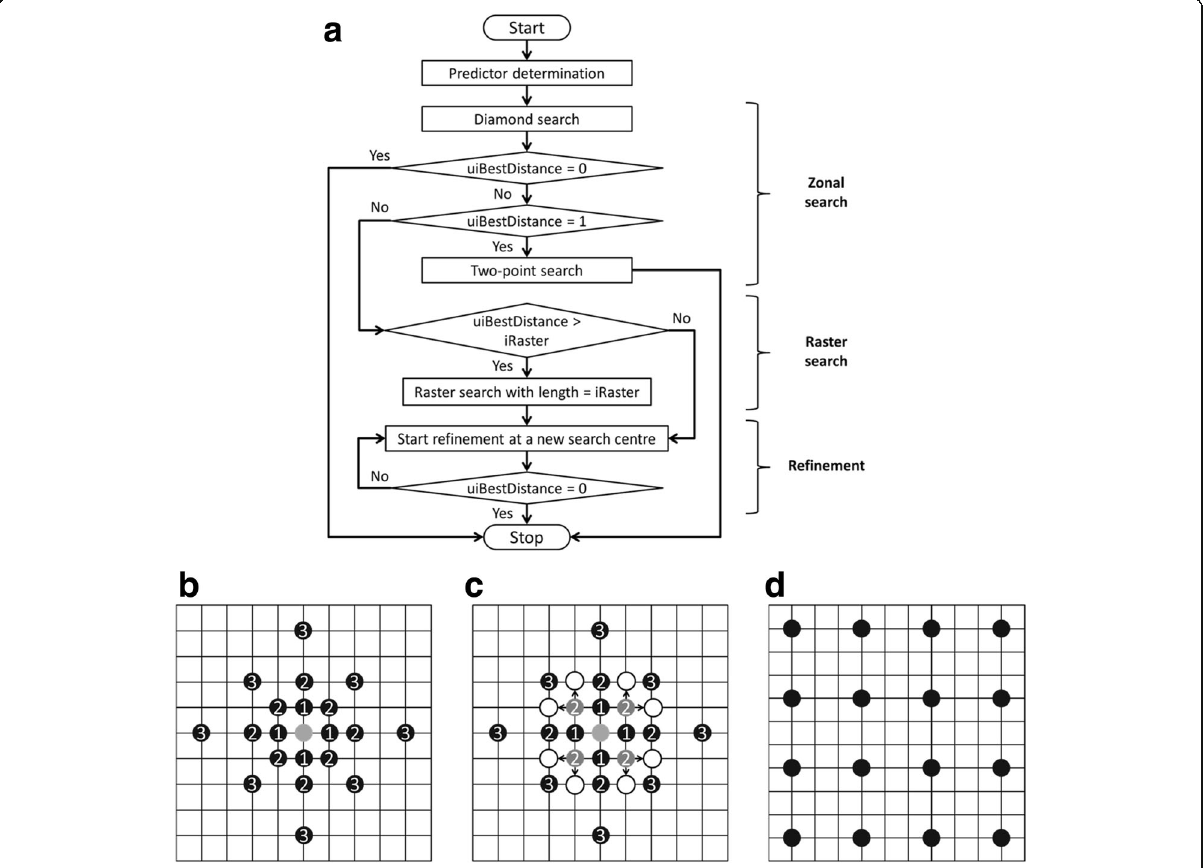
Fig. 1 The conventional TZ search algorithm. a Flowchart of the conventional TZ search algorithm. b Eight-point diamond search pattern. c Two-point search. d Raster search when iRaster =